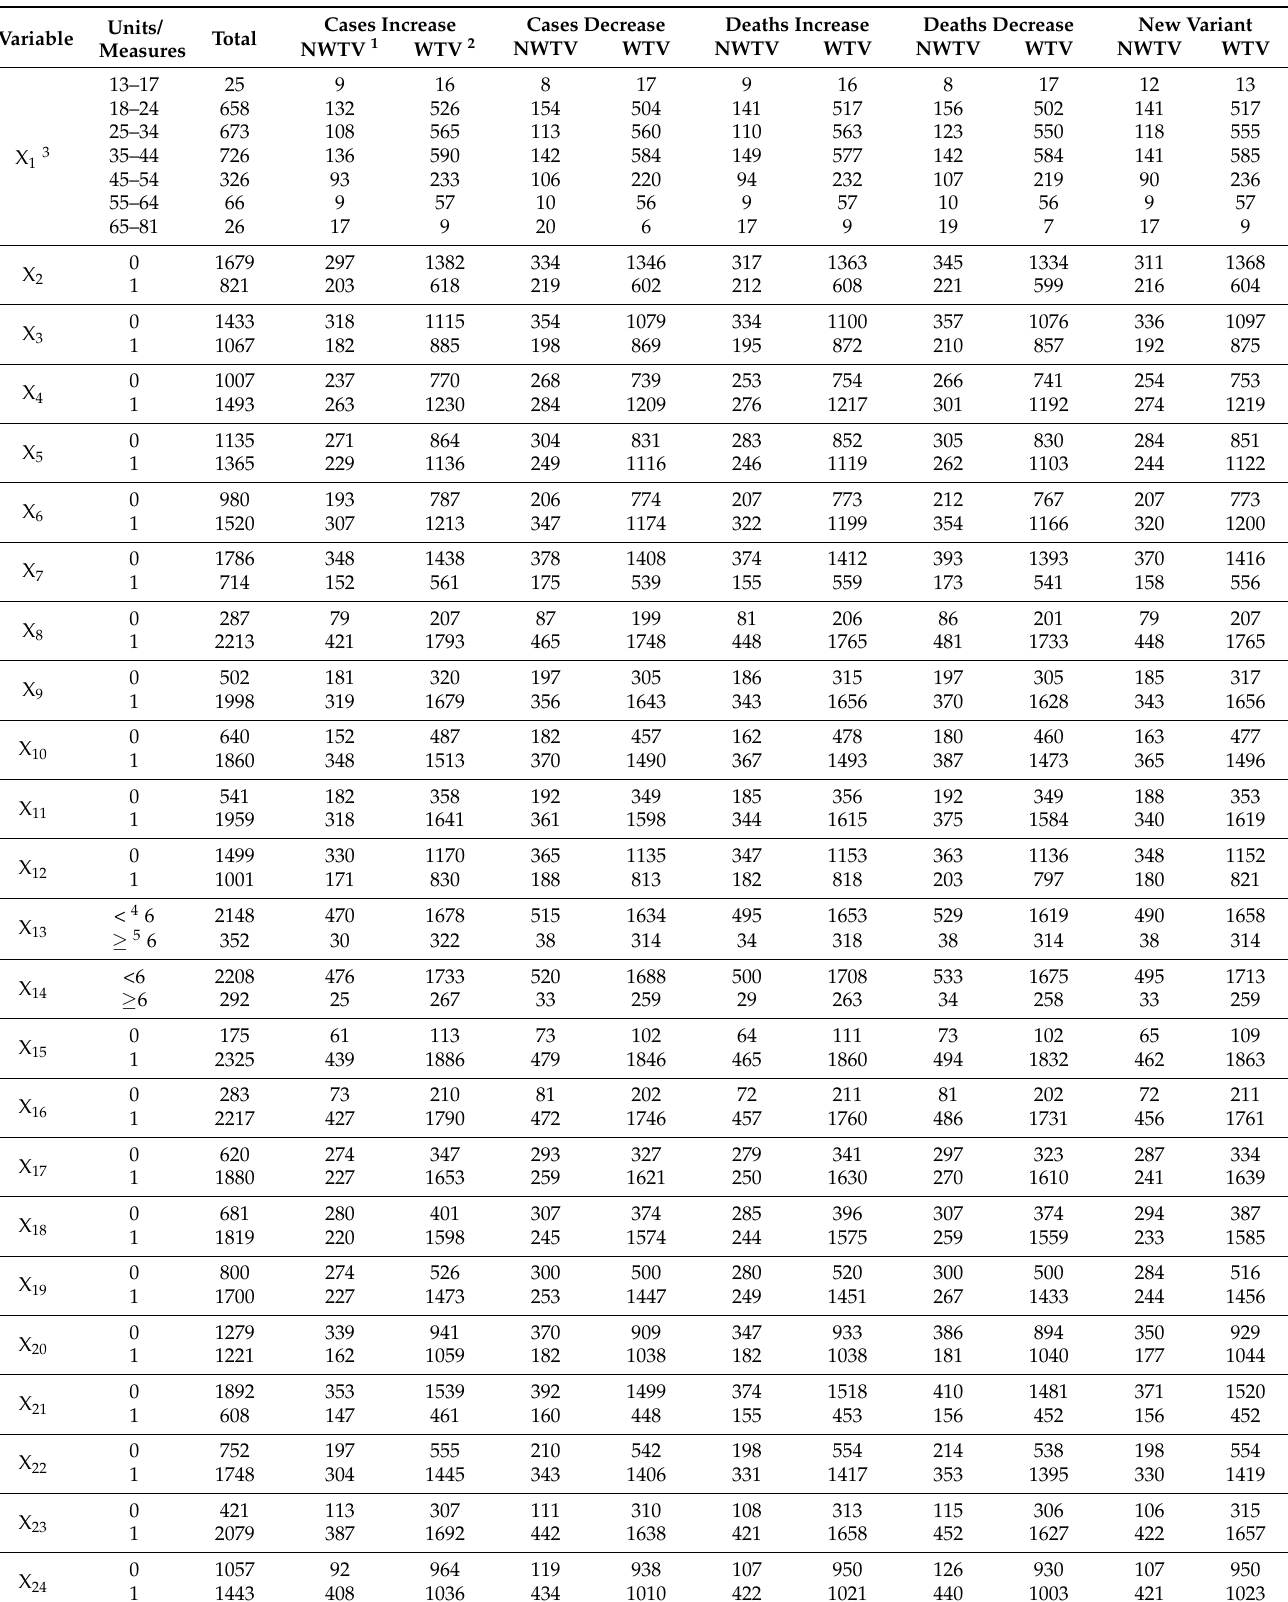
Table 1. COVID-19 vaccine acceptance with different levels of pandemic